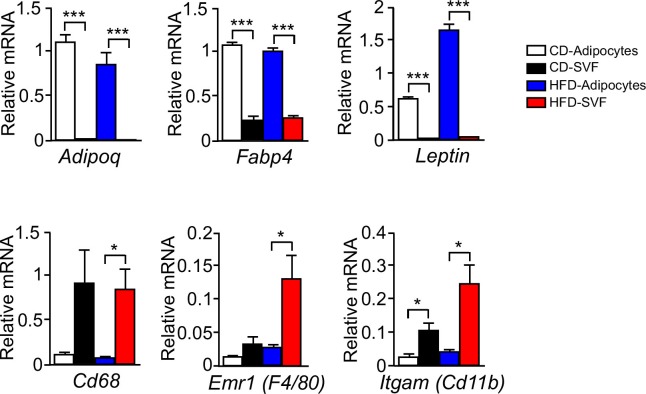
Expression of adipocyte and stromal vascular fraction marker genes.Epididymal fat pads of CD-fed and HFD-fed (16 wk) wild-type mice were used to isolate adipocytes and the stromal vascular fraction (SVF). The expression of adipocyte and SVF marker genes were examined by measurement of mRNA by quantitative RT-PCR (mean ± SEM; n = 4~6; *p<0.05; ***p<0.001). These data demonstrate that adipocyte marker genes Adipoq and Leptin were not expressed by the SVF, but low level expression of the SVF marker genes Emr1 (F4/80), Itgam (Cd11b), and Cd68 was detected the adipocyte fraction. This SVF contamination of the adipocyte fraction may be mediated by lipid-loaded macrophages (Xu et al., 2013). Control studies were performed using a gene (Fabp4) that is expressed by both adipocytes and SVF.